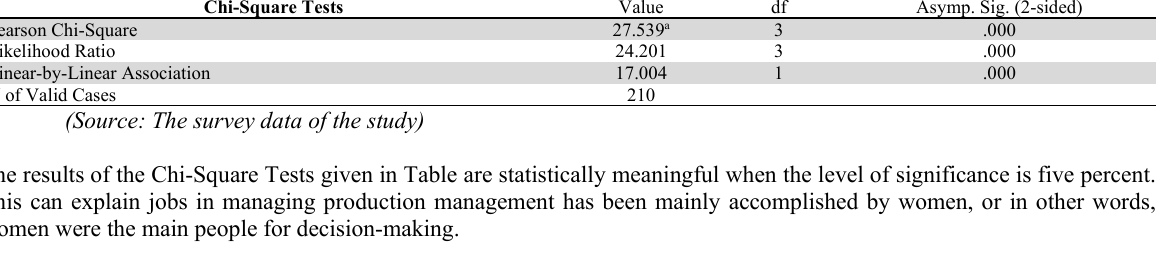
Chi-Square Tests on decision making in managing production and income generation